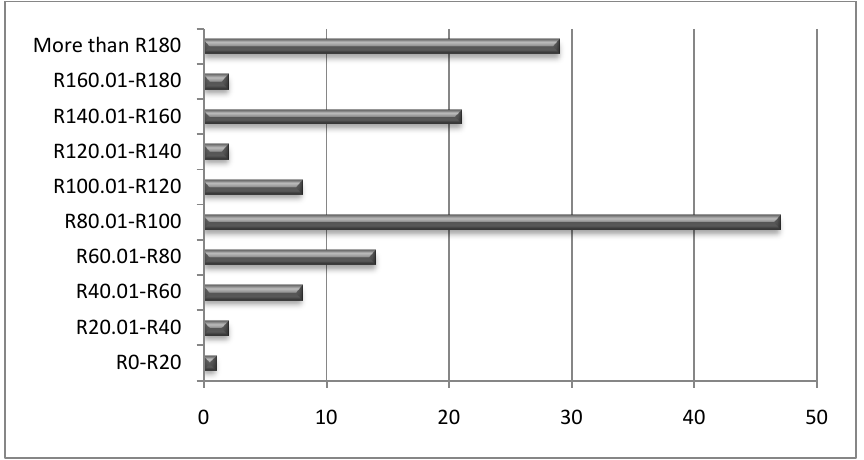
FIGURE 10: The average tips per shift in Kempton Park, 2008 Source: Survey data (2008)